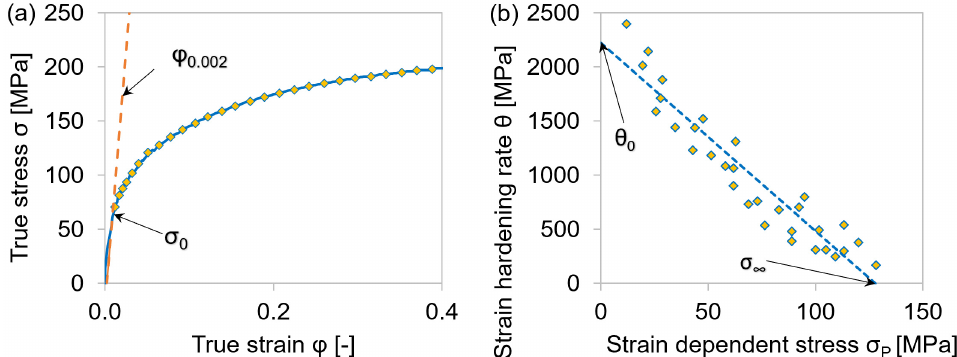
Figure A2. ( a ) Exemplary stress–strain curve with smoothed values; ( b ) linear fit of corresponding Kocks plot.